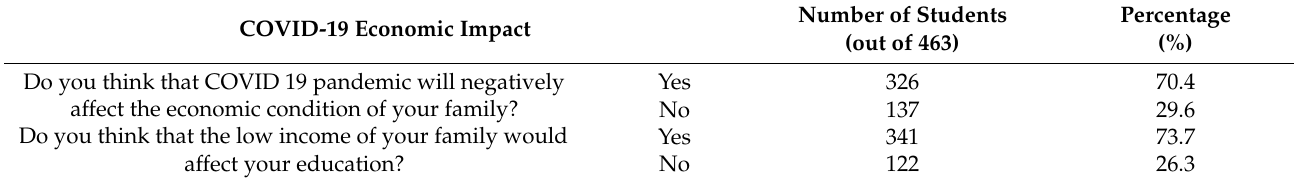
Table 7. COVID-19 economic impact on education.